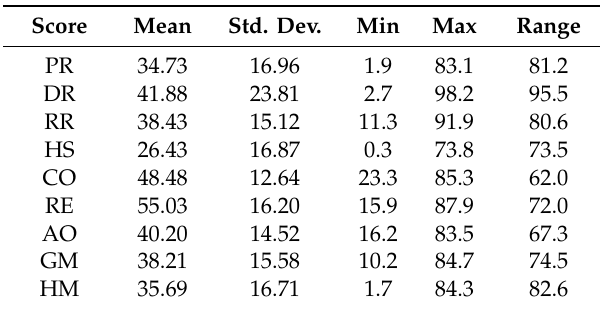
Table 1. Descriptive statistics for numerical score